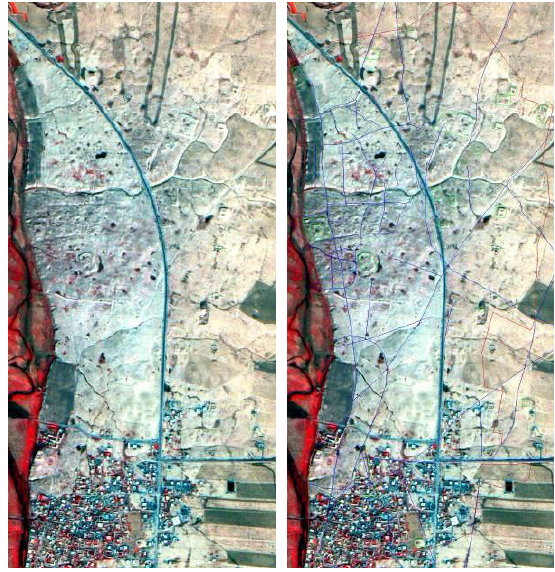
Figure 6 - a NIRGB synthesis of the FORMOSAT-2 image (acquired on 24. 10. 2014) with an overlaid objects of interest on the right picture (Cemetery – yellow, city outline – red, features found on site – green, historic routes – blue). If an object of interest is assumed as a line or is defined by sharp edges, filtering methods provide a powerful tool for its highlight. An example is shown on Figure 7.